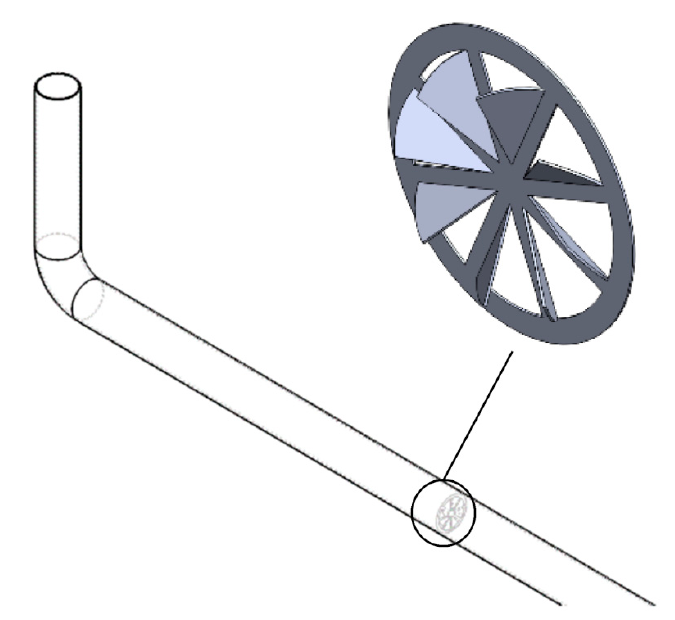
Figure 3. Turbulent insert pipe.